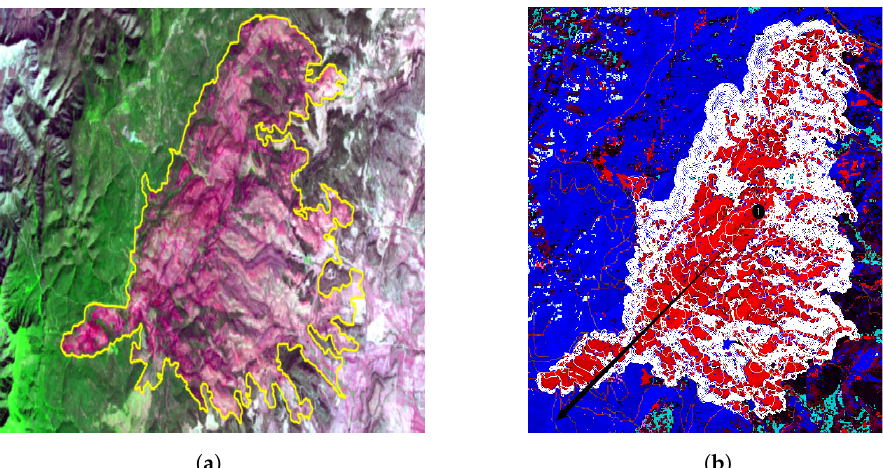
Figure 16. Comparison between the actual combustion area and simulation region of DogHead wildfire. ( a ) The actual combustion area. ( b ) The result of